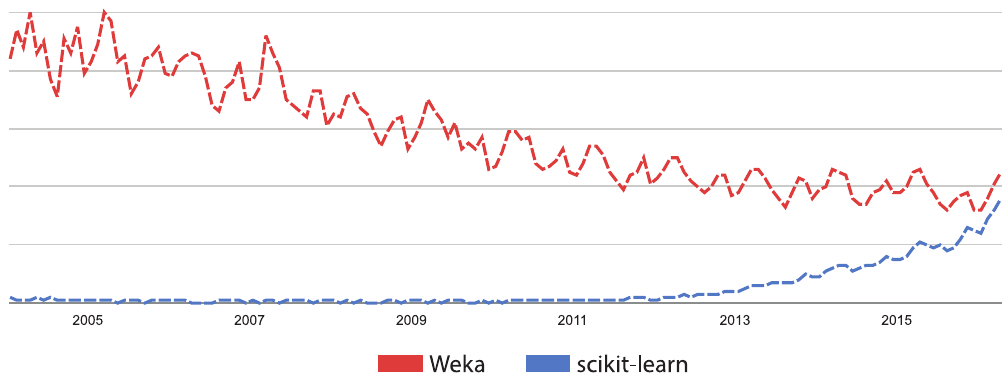
Figure 1. Search interest through time of both WEKA and scikit-learn. Source: Google Trends [37].